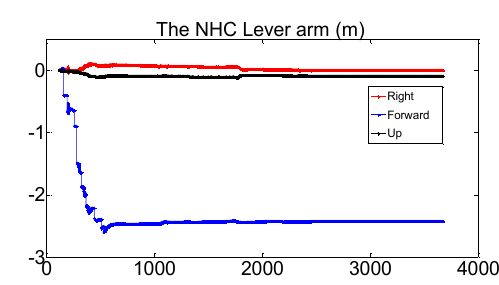
Figure 8. The NHC lever arm in real tunnel experiment (Red: the right lever arm; Blue: the forward lever arm; Black: the height lever arm)